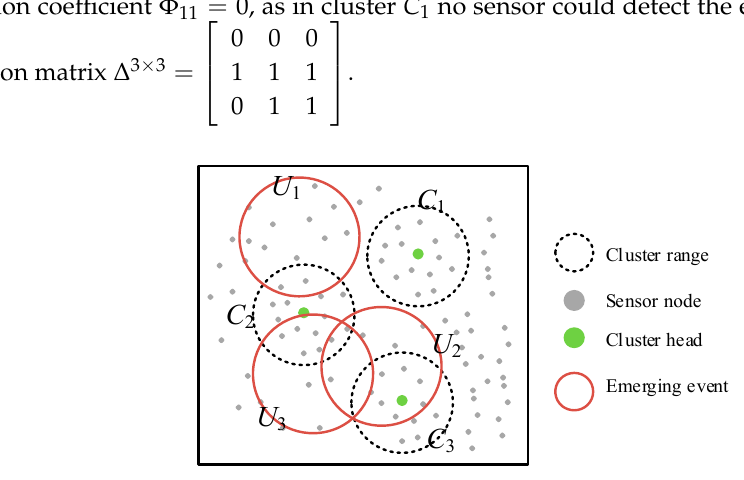
Figure 2. Modelling of Event correlation coefficient.